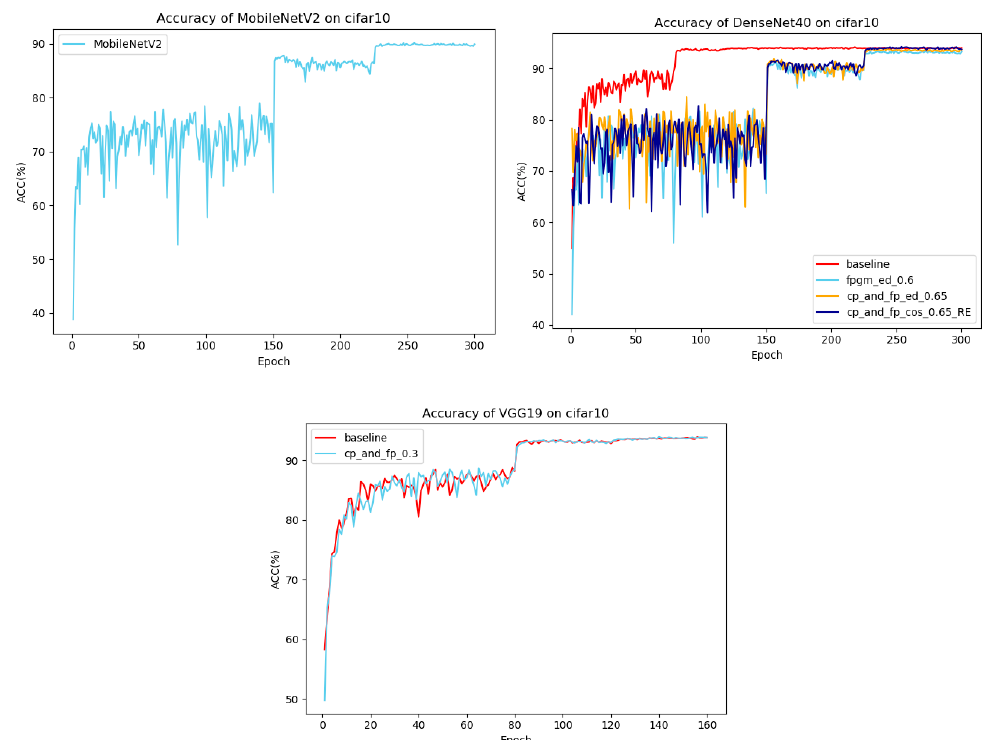
Figure 3. Changes of accuracy of Densenet40, VGG19 and MobileNetV2 on CIFAR10 data set.